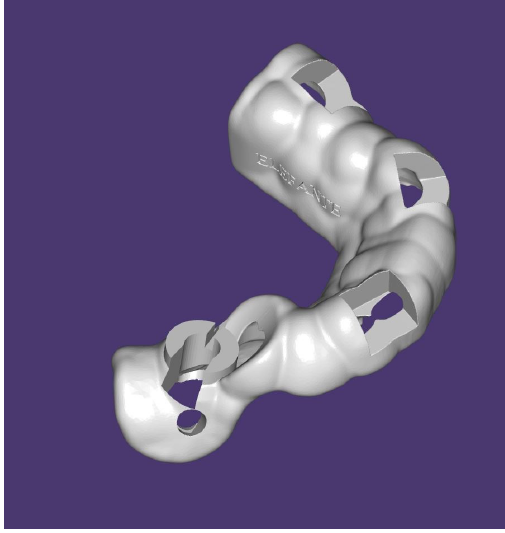
Figure 3. Surgical template without metallic sleeves: Open sleeves.